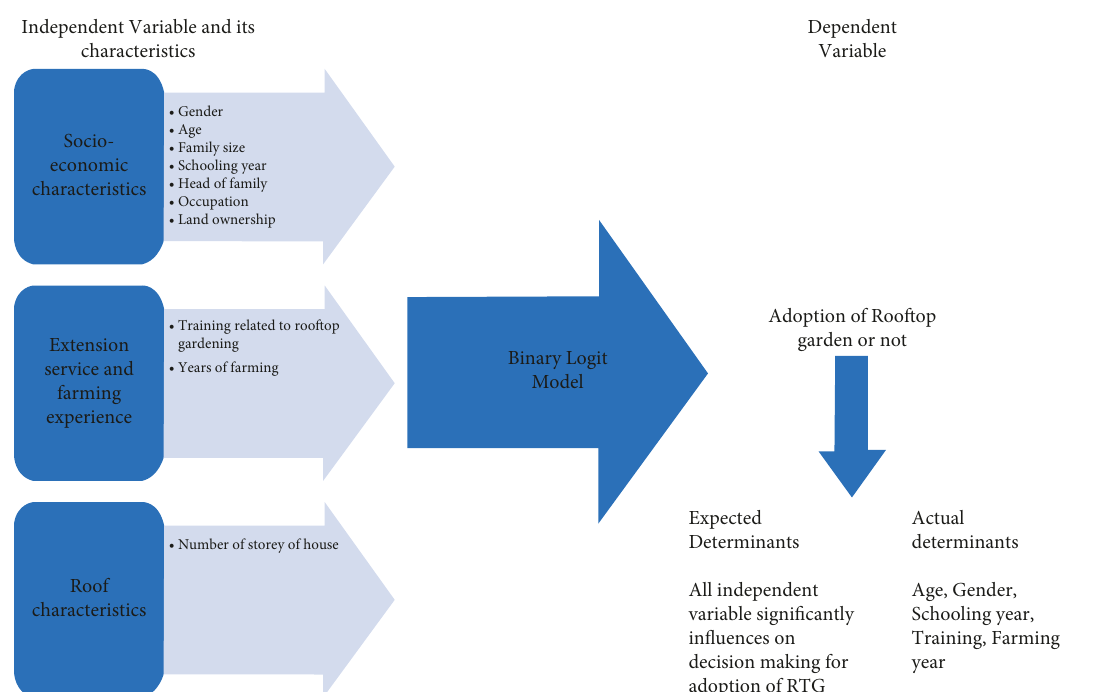
Figure 3: Conceptual framework of using binary logit model and variables used.